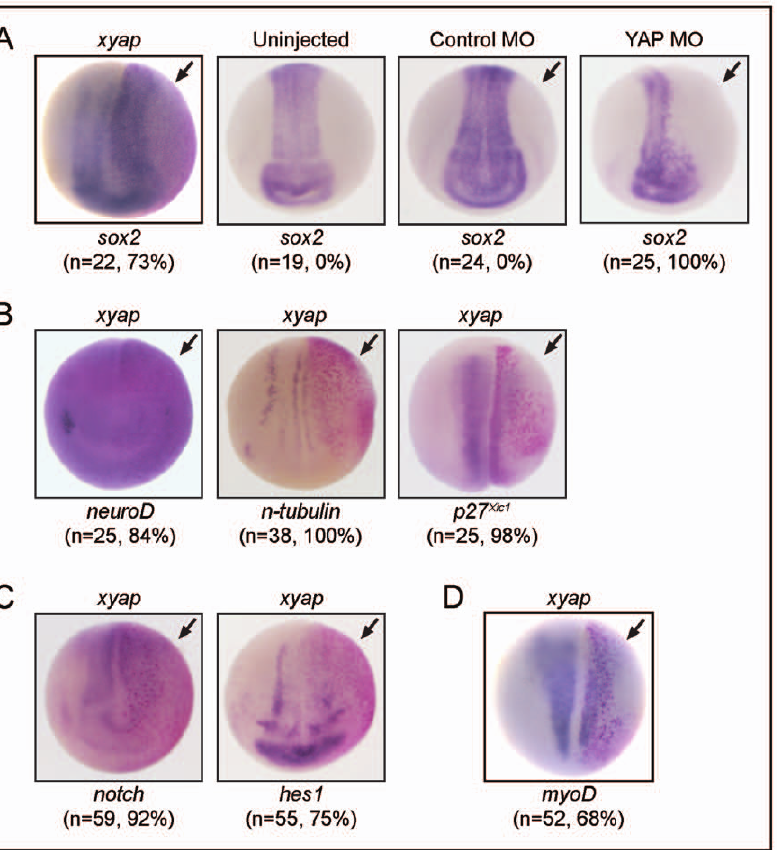
Figure 4. xYAP gain-of-function expands neural progenitor fields, while neural differentiation is inhibited. ( A ) The neural plate progenitor field marked by sox2 expression (blue stain) was darker, longer, and/or wider on the xYAP-injected side (arrow, red b -gal staining) compared to the uninjected side of the same embryo. xYAP MO-mediated knockdown (40 ng) eliminated sox2 expression on the injected side, whereas a control MO (cMO) did not. In this and all subsequent panels: n=sample size; %=frequency of the phenotype; arrow indicates injected side. ( B ) Three genes indicative of neural differentiation ( neuroD , n-tubulin , p27 Xic1 ) were inhibited by xYAP gain-of-function. ( C ) xYAP gain-of-function reduced notch and hes1 expression. ( D ) Muscle differentiation marker, myoD , was reduced by xYAP gain-of-function. All views are dorsal-anterior.